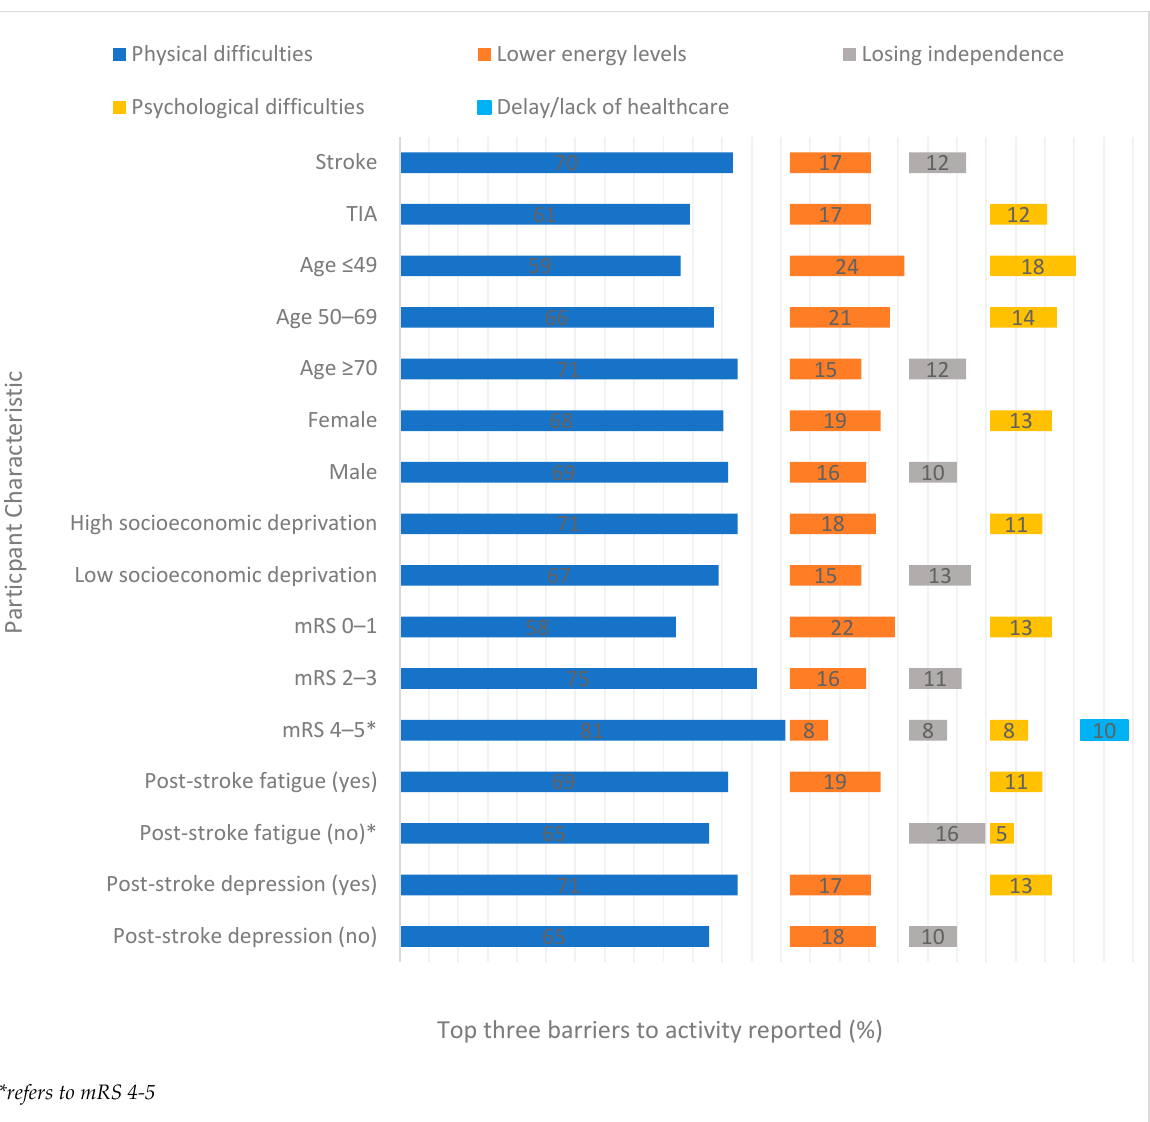
Figure 1. The three most reported barriers to activity (%) at 6 month follow-up by participant char- acteristic.